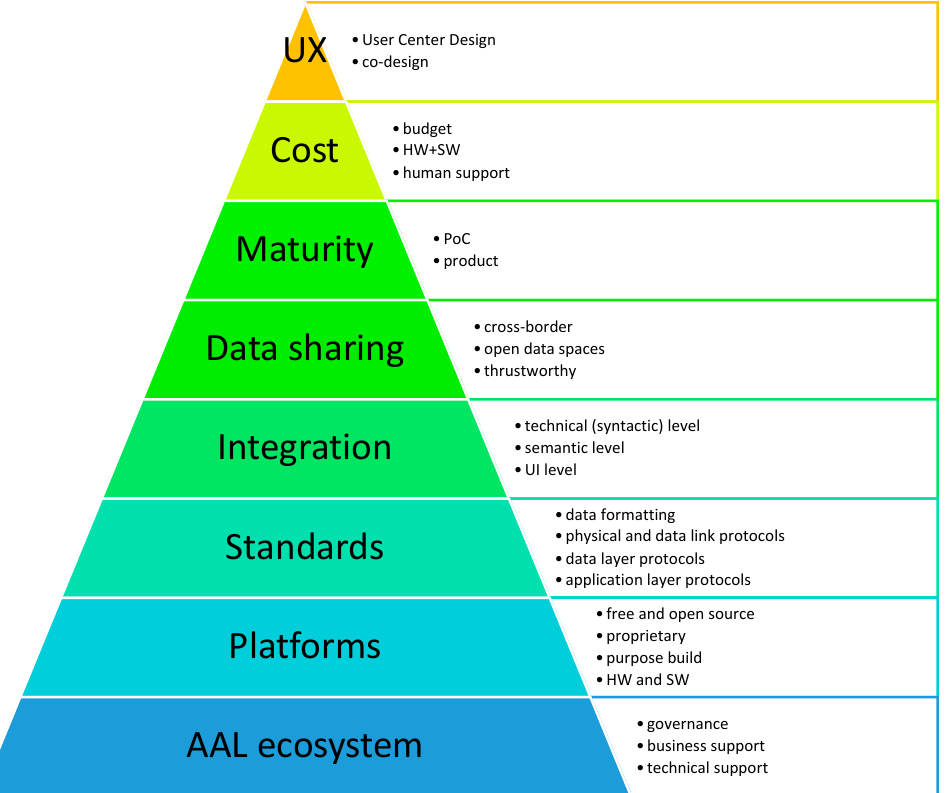
Figure 13. Challenges and choices in the AAL domain.